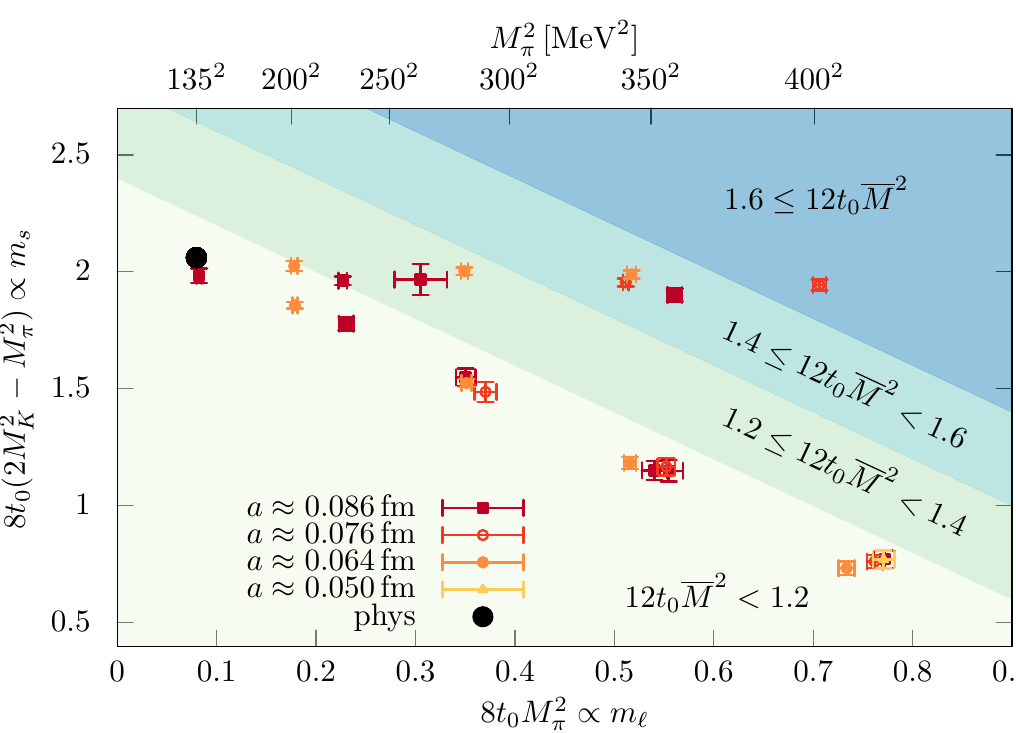
Figure 1. The positions of the analysed CLS ensembles in the quark mass plane. Two mass trajectories were realized that intersect approximately at the physical point (black circle). Along one trajectory the average quark mass is held fixed, along the other trajectory the strange quark mass is kept approximately constant. The symbols encode the four lattice spacings while the shaded areas indicate the values of the average squared pseudoscalar mass M 2 , see eq. (3.4). At the physical M 2 ≈ 1 . 11 , where (8 t ph point, 12 t ph ) − 1 / 2 ≈ 0 . 475 GeV 0 0